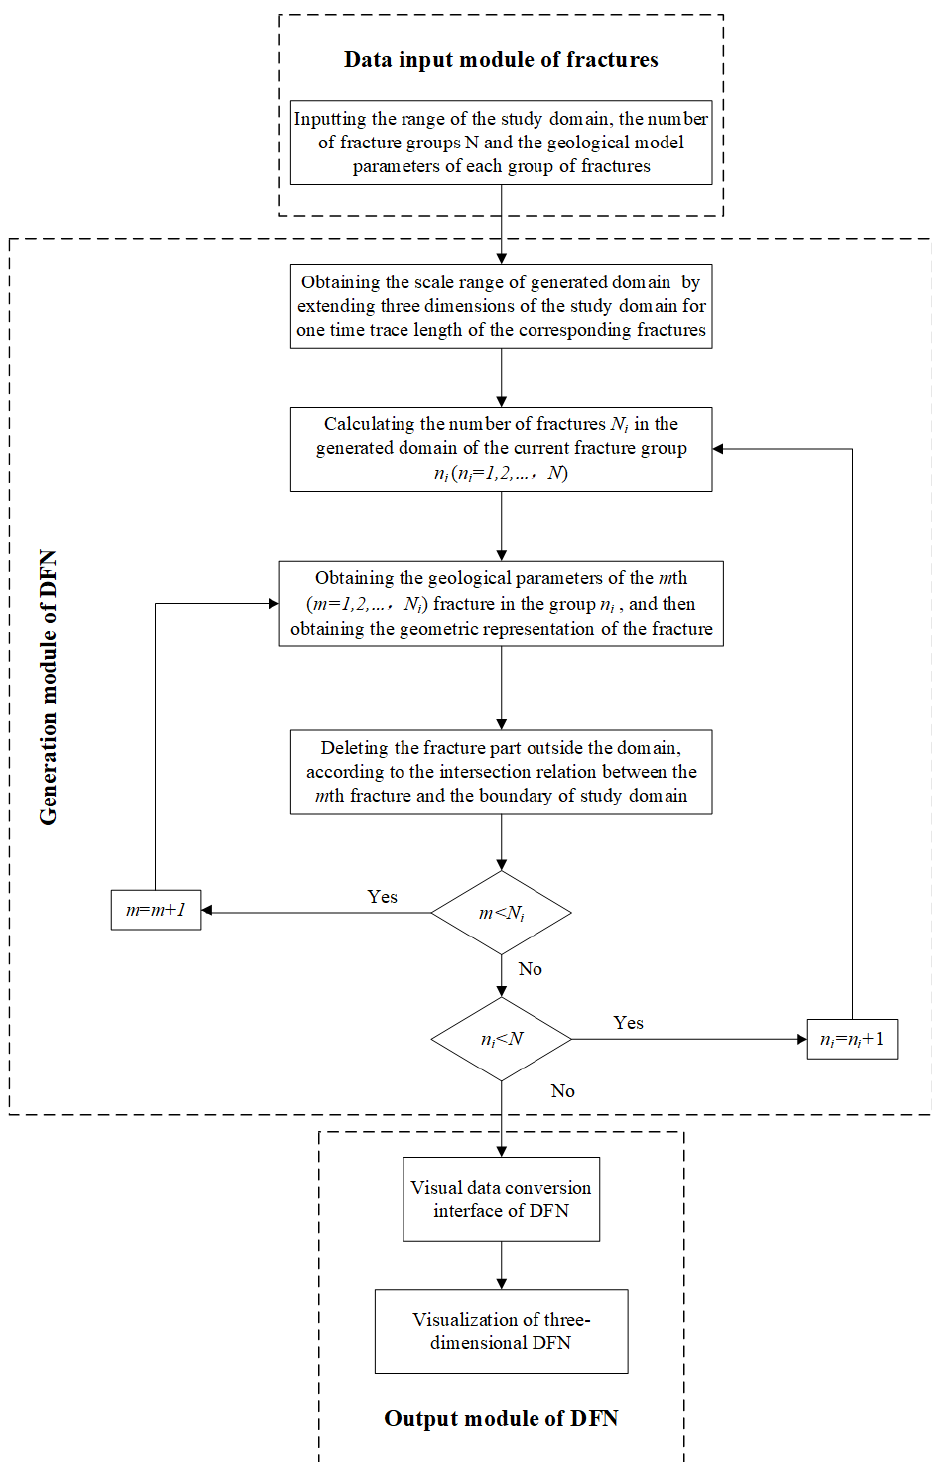
Figure 3. Flow of implementation of the DFN simulation, and the relationship between modules.